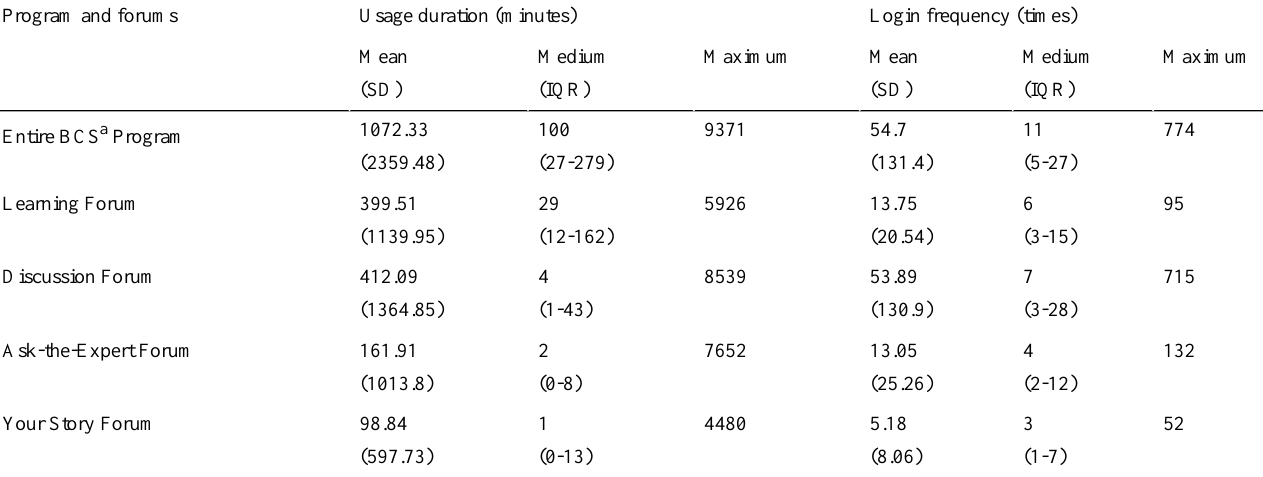
Table 1. Usage duration and login frequency of Breast Cancer e-Support program for women with breast cancer receiving chemotherapy during the 12-week intervention